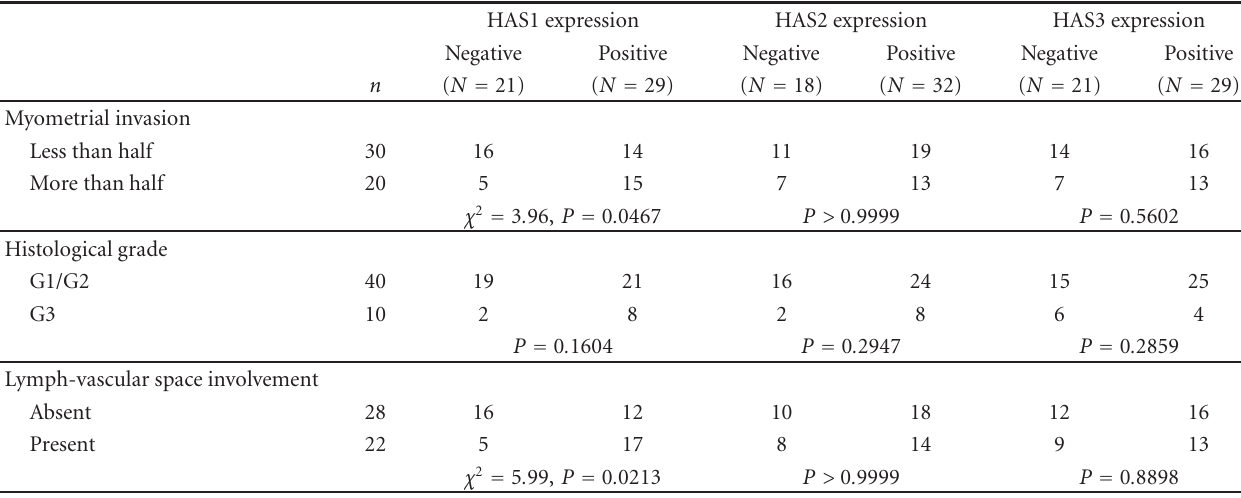
Figure 1: Immunohistochemical visualization of HAS1, HAS2, and HAS3 in endometrioid adenocarcinoma of the uterine corpus ( × 400). Table 1: Expression of HAS1, HAS2, and HAS3 in relation to the depth of myometrial invasion, histological grade, and lymph-vascular space involvement in patients with endometrial cancer.